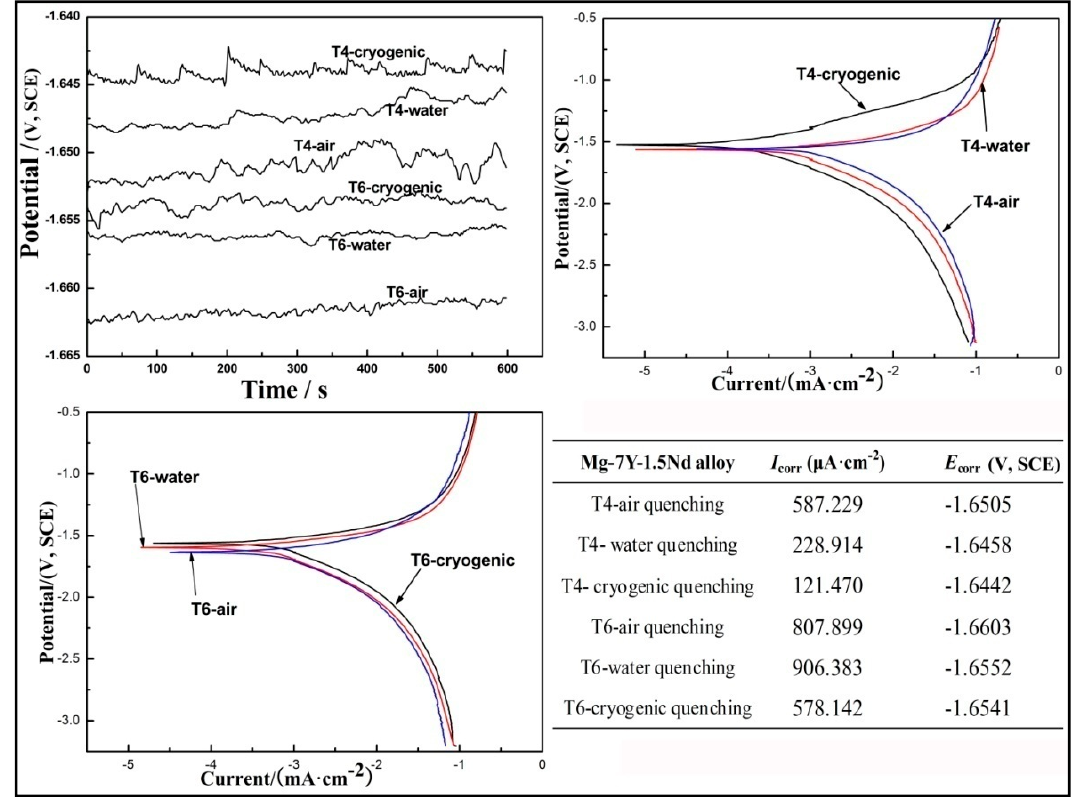
Figure 11. Electrochemical tests of Mg-7Y-1.5Nd alloy measured in 3.5% NaCl solution with the corrosion potential ( E corr ) and the corrosion current ( I corr ); SCE: Saturated calomel electrode.